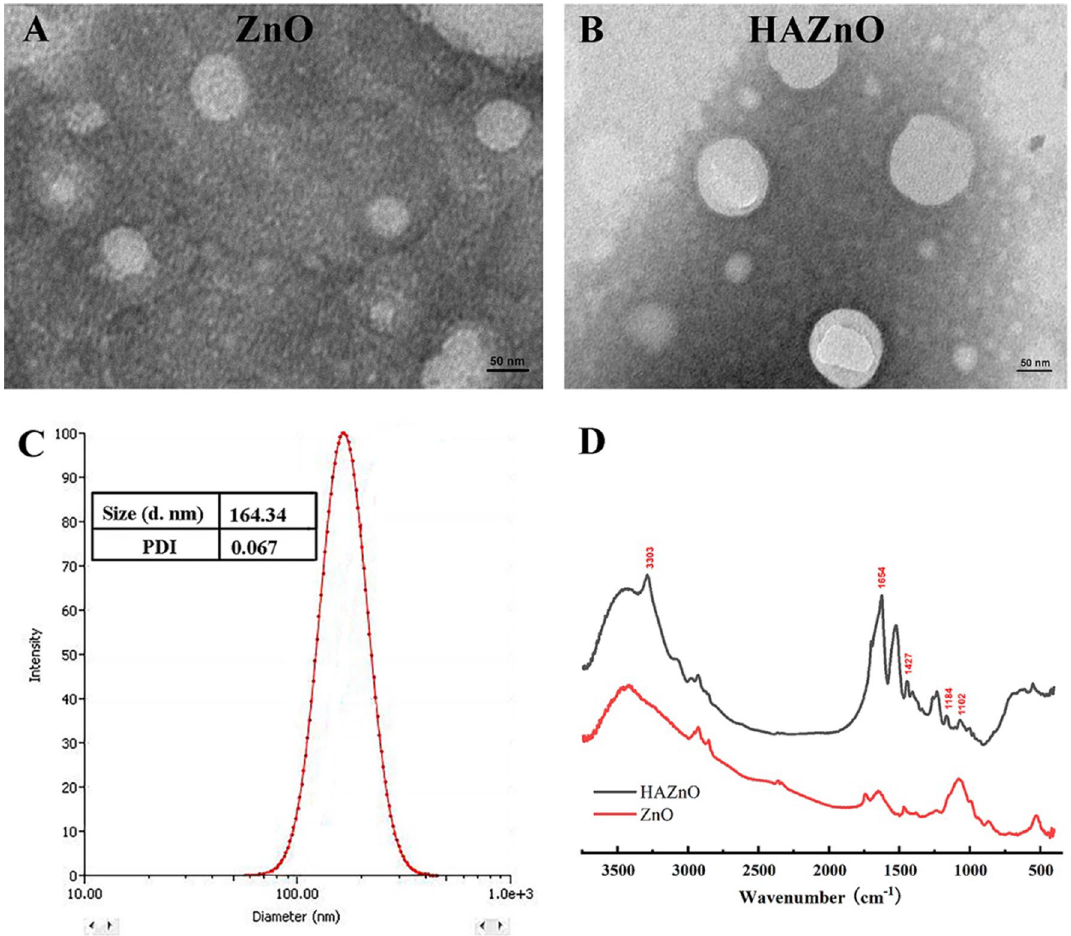
Figure 2. ( A ) TEM image of ZnO NPs; ( B ) TEM image of HAZnO NPs; ( C ) Size distribution of HAZnO NPs (DLS measurement); ( D ) FTIR spectrum of ZnO and HAZnO